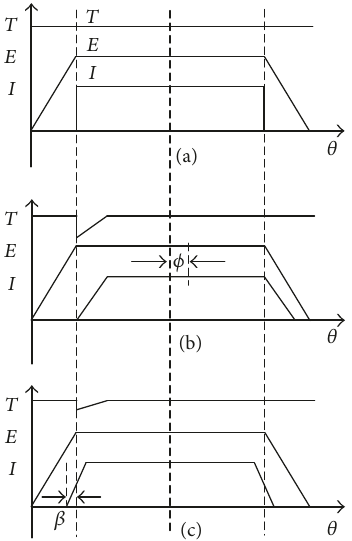
Figure 2: The torque, back-EMF, and phase current: (a) ideal case; (b) actual case; (c) advanced 𝛽 electrical angle.